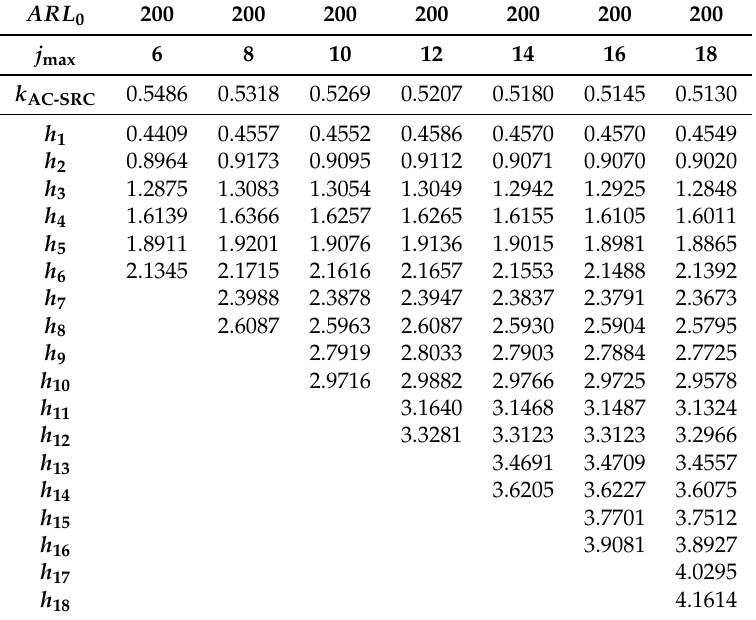
Table A2. AC-SRC for ARL 0 = 200.